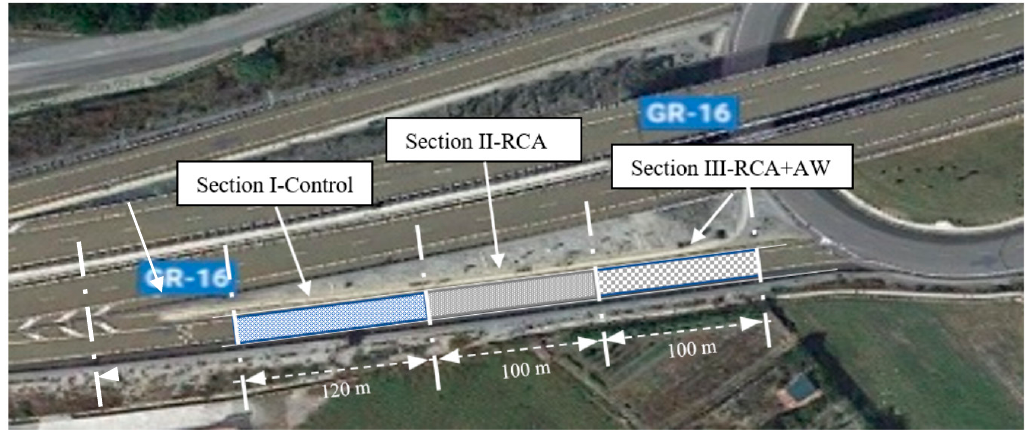
Figure 1. General view of the road section.